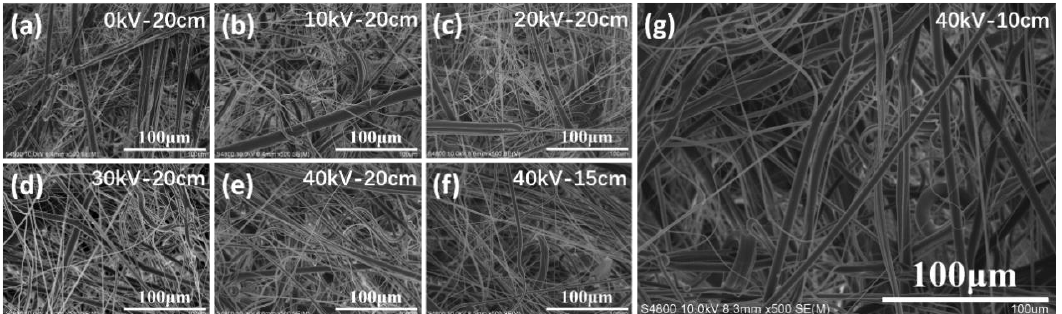
Figure 2. SEM graphs of the polypropylene (PP) microfiber prepared under different voltages or electric field distances by electrostatic-assisted melt blown. ( a ) to ( e ) show PP microfiber prepared in voltage of 0 kV ( a ), 10 kV ( b ), 20 kV ( c ), 30 kV ( d ) and 40 kV ( e ); ( e ) to ( g ) show PP microfiber prepared in electric field distance of 20 cm ( e ), 15 cm ( f ) and 10 cm ( g ).